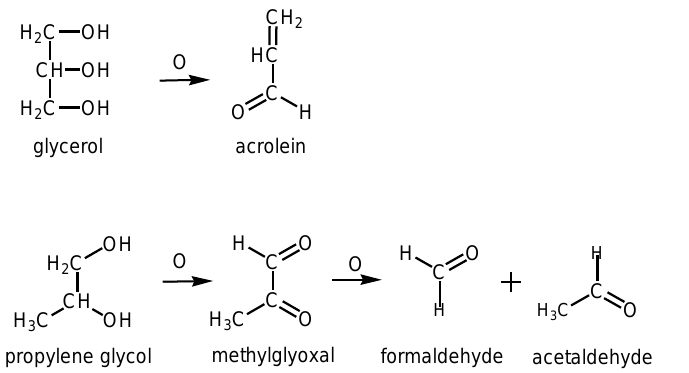
Figure 1. Oxidation of e-liquid (glycerol and propylene glycol) with nichrome wire (reproduced from [14] with permission from The Japan Society for Analytical